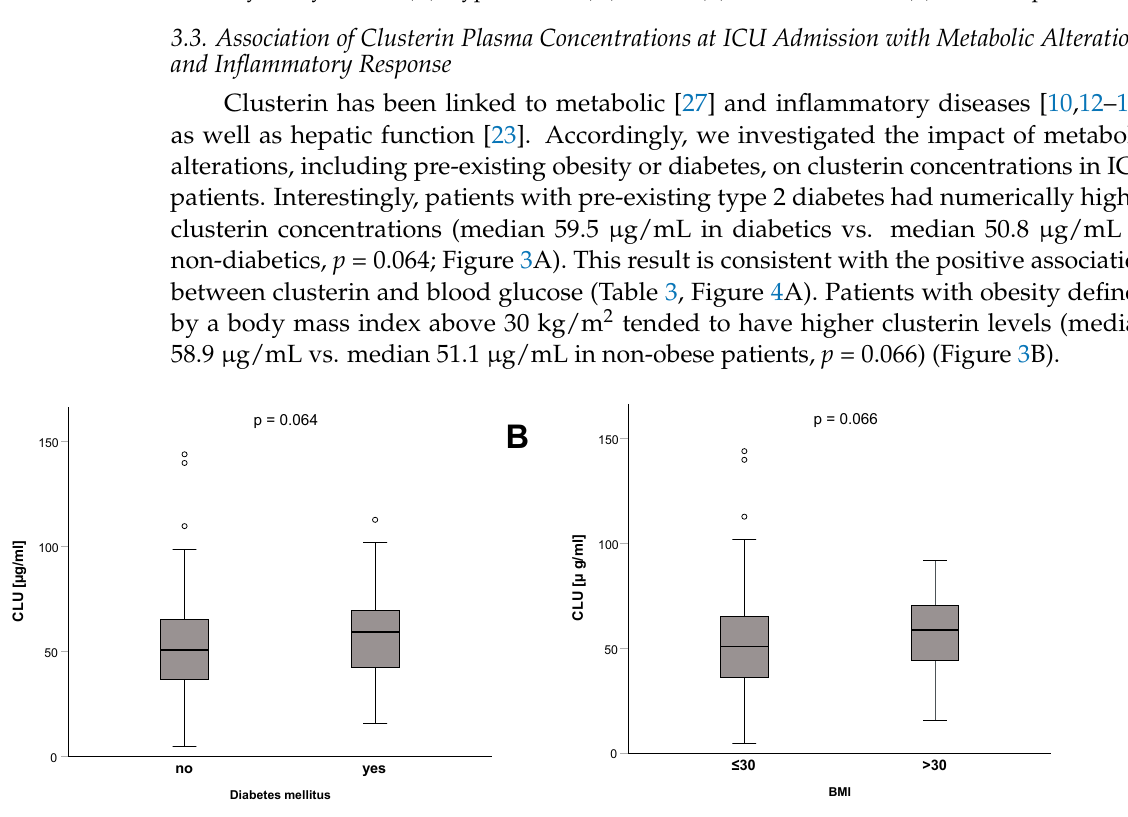
Figure 2. Clusterin levels are not influenced by sex, age, or comorbidities. Clusterin plasma concentrations were not influenced by patient sex ( A ), age ( B ), or pre-existing chronic diseases, such as coronary artery disease ( C ), hypertension ( D ), COPD ( E ), or liver cirrhosis ( F ). Circle depicts outlier.